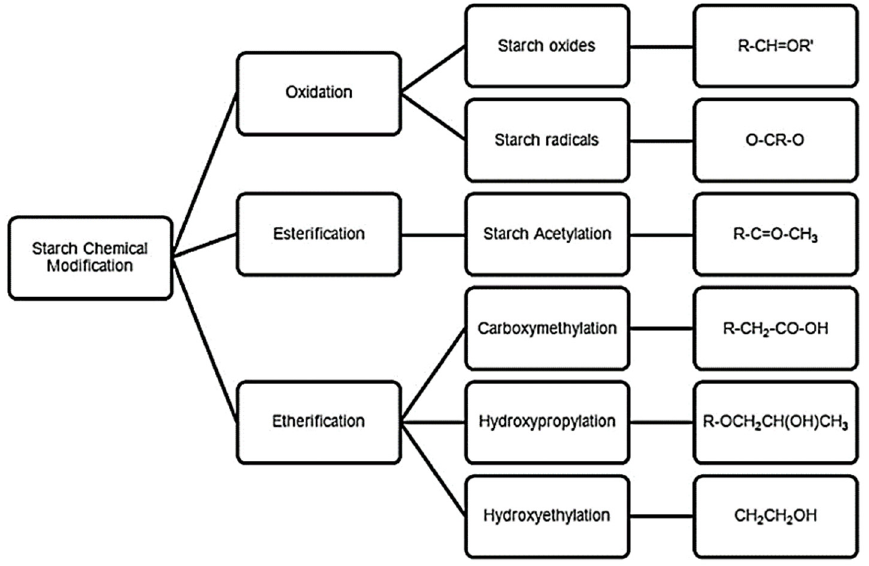
Figure 5. Diagram outlining the classical chemical techniques for starch modification [83].